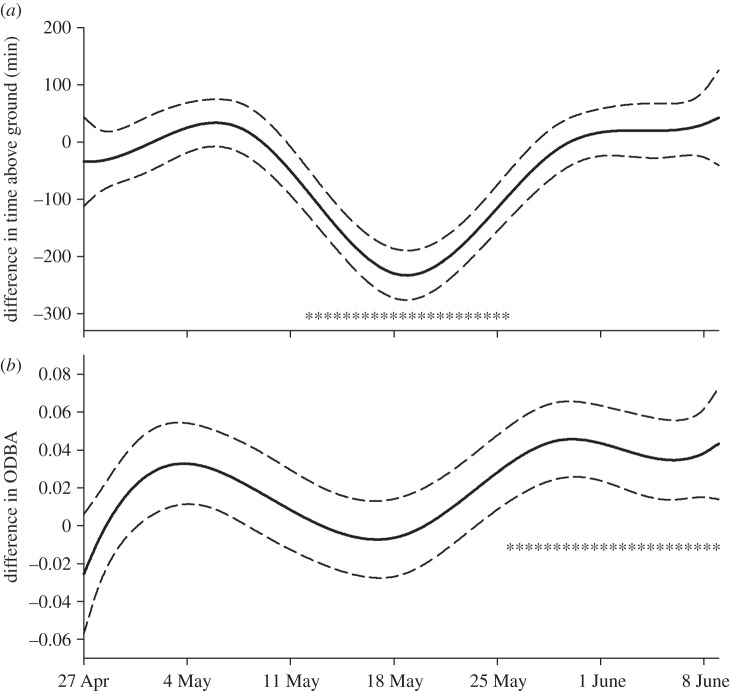
Predicted differences between the sexes in p-splines for (a) time (min) spent above ground each day and (b) mean daily ODBA of arctic ground squirrels from Atigun River, 27 April–9 June 2015. The solid lines show the mean predictions and the dotted lines, the 95% CIs. Negative values indicate females spend less time above ground or have lower ODBA compared with males. Asterisks indicate time intervals with significant differences (p < 0.05; Holm's step-down adjustment for multiple comparisons).